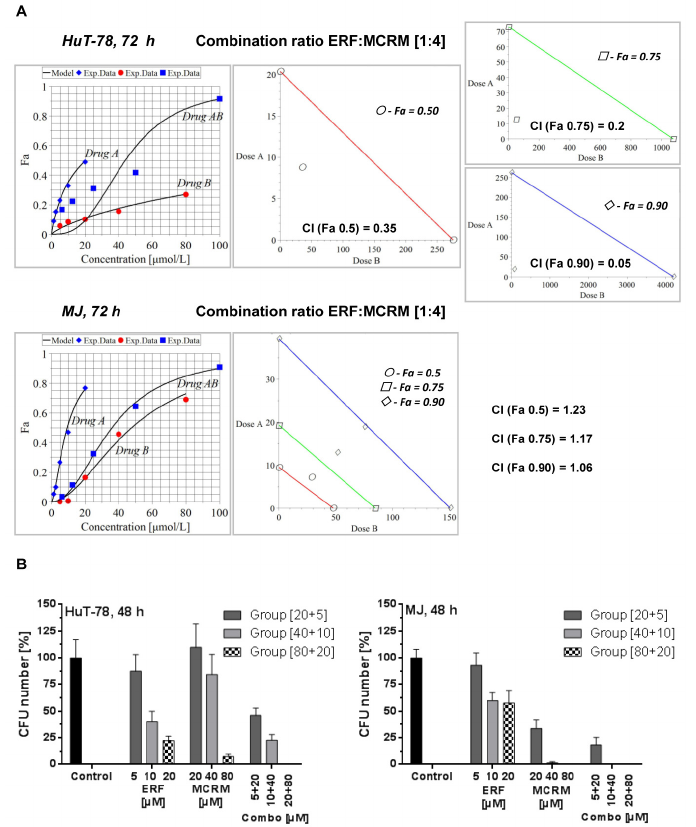
Figure 3. Synergistic and additive combinations between erufosine and micellar curcumin with an inhibitory effect on cell proliferation and clonogenicity of the cell lines HuT-78 and MJ. Legend: ( A )–isobolograms for HuT-78 and MJ cells, calculated by MAPLE software from a MTT assay, where CI stands for Combination Index, Fa 0.5 is the median cytotoxic effect (denoted with points), Fa 0.75 is the effect killing 75% of the cells (denoted with squares) and Fa 0.9 is equal to 90% dead cells (denoted with rhombuses); ( B )—clonogenic survival (CFU assay) of lymphoblasts from the TWIST1 expressing cell lines HuT-78 and MJ after treatment with combinations achieving Fa 0.9, including the single drug effects of the respective concentrations. Drug A stands for ERF, Drug B stands for MCRM and Drug AB stands for combination between ERF and MCRM.